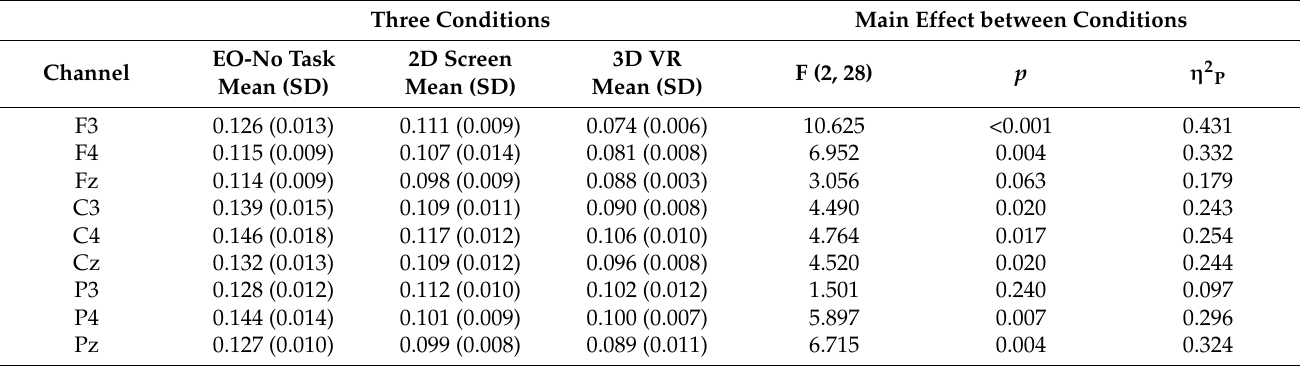
Table 4. Relative EEG alpha power for the three conditions EO-no task, 2D screen and 3D VR.